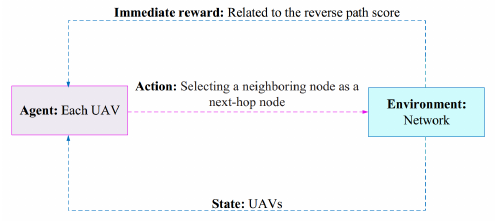
Figure 36. Learning process in PARRoT. Table 18. The most important advantages and disadvantages of